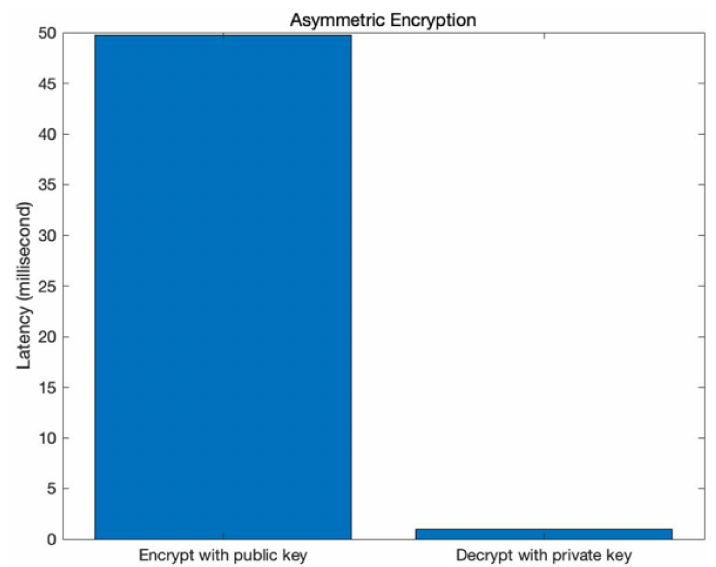
Figure 12. Asymmetric Encryption